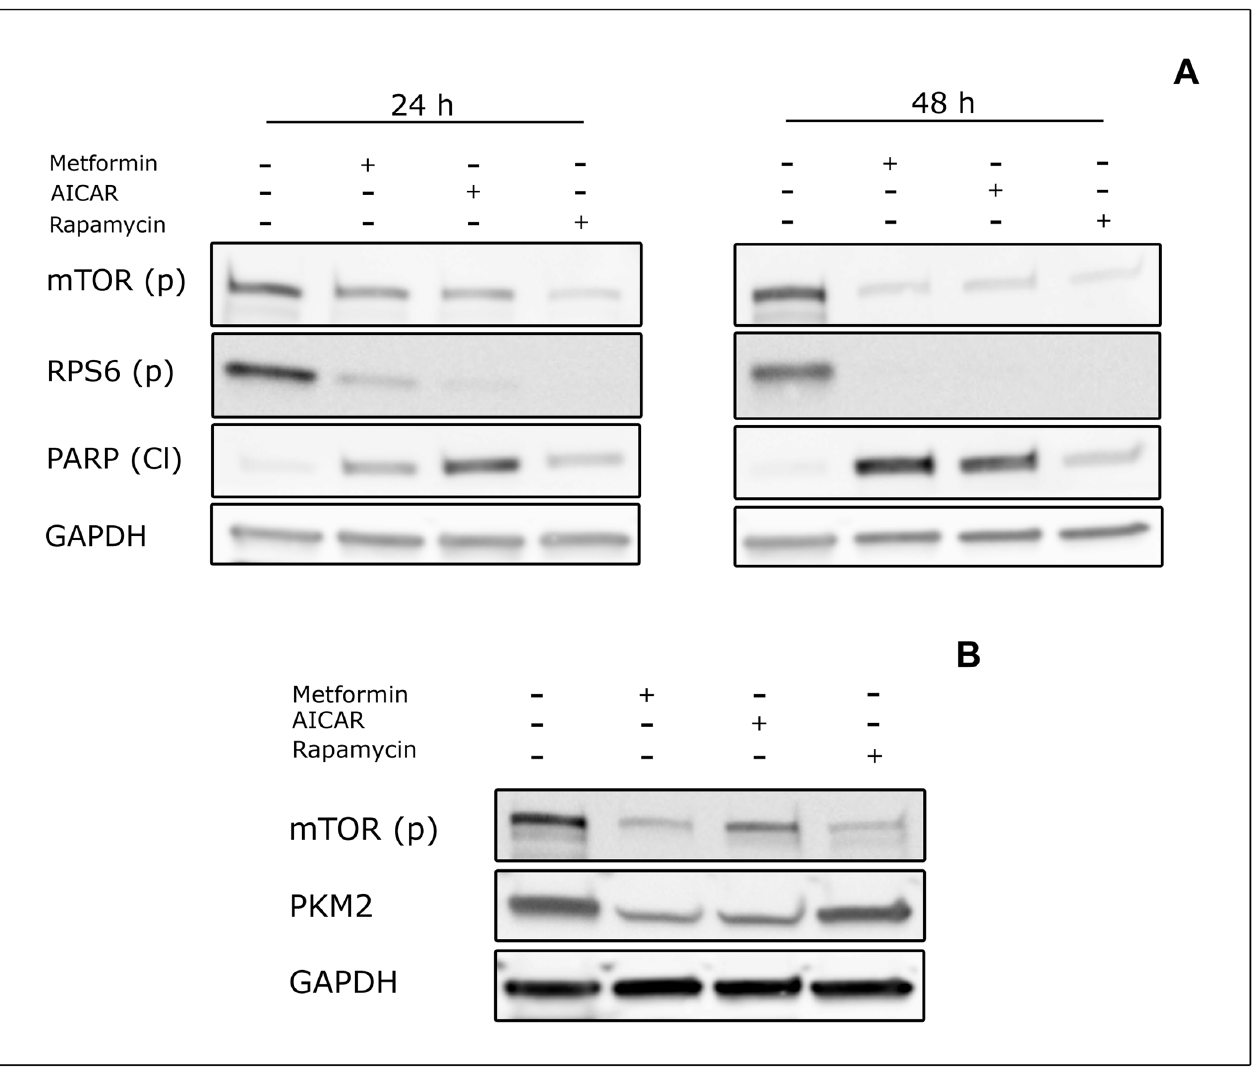
Fig 6. AMPK activation by AICAR is sufficient to induce apoptosis and downregulation of PKM2. A) MCF7 cells were plated at 8X10 5 cells/well in 6-well plates in MEM medium and treated with 10 mM metformin, 3 mM AICAR, 100 nM rapamycin or PBS as control, for 48 hours. After treatment cells were lysed and protein extracts were analysed by Western Blot with antibodies directed against mTOR (p) Ser2448, RPS6 (p) Ser240/244 and PARP (Cl). GAPDH was used as loading control. B) MCF7 cells were plated at 8X10 5 cells/well in 6-well plates in MEM medium and treated with 10 mM metformin, 3 mM AICAR, 100 nM Rapamycin or PBS as control for 48 hours. After treatment cells were lysed and protein extracts were analysed by Western Blot with anti- mTOR (p) Ser2448 and anti-PKM2 antibodies. GAPDH was used as loading